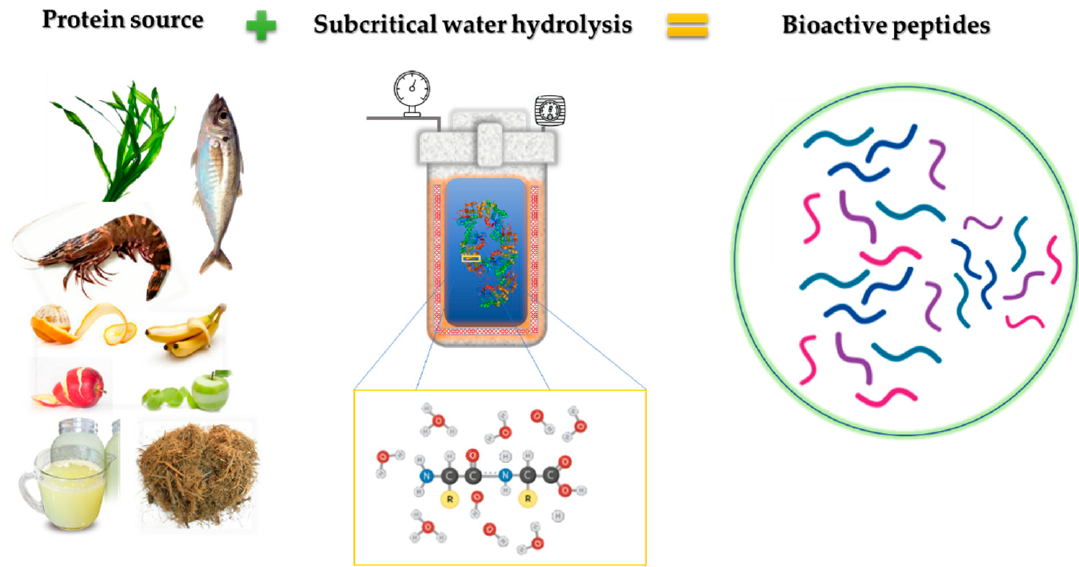
Figure 1. SWH general scheme .